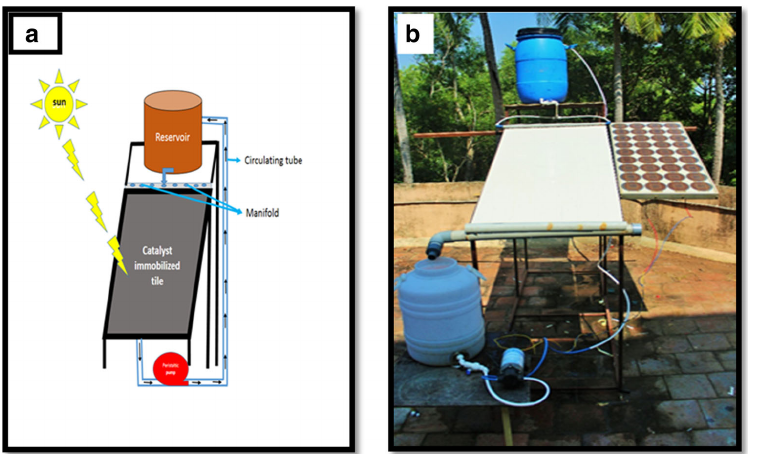
Figure 23. Scheme ( a ) and built prototype ( b ) of a thin film plate reactor for purifying sugar refinery wastewater. (Reprinted/adapted with permission from Ref.